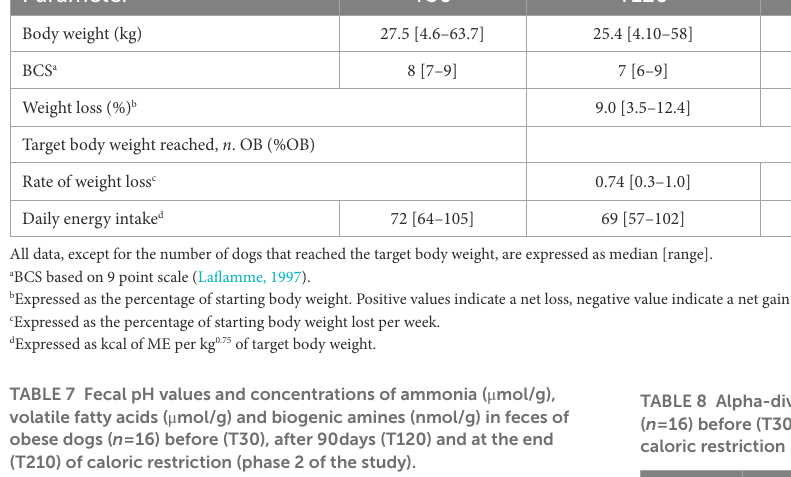
TABLE 6 Weight loss outcomes of obese dogs ( n = 16) before (T30), after 3 months (T120), and at the end (T210) of caloric restriction (phase 2 of the study). Parameter T30